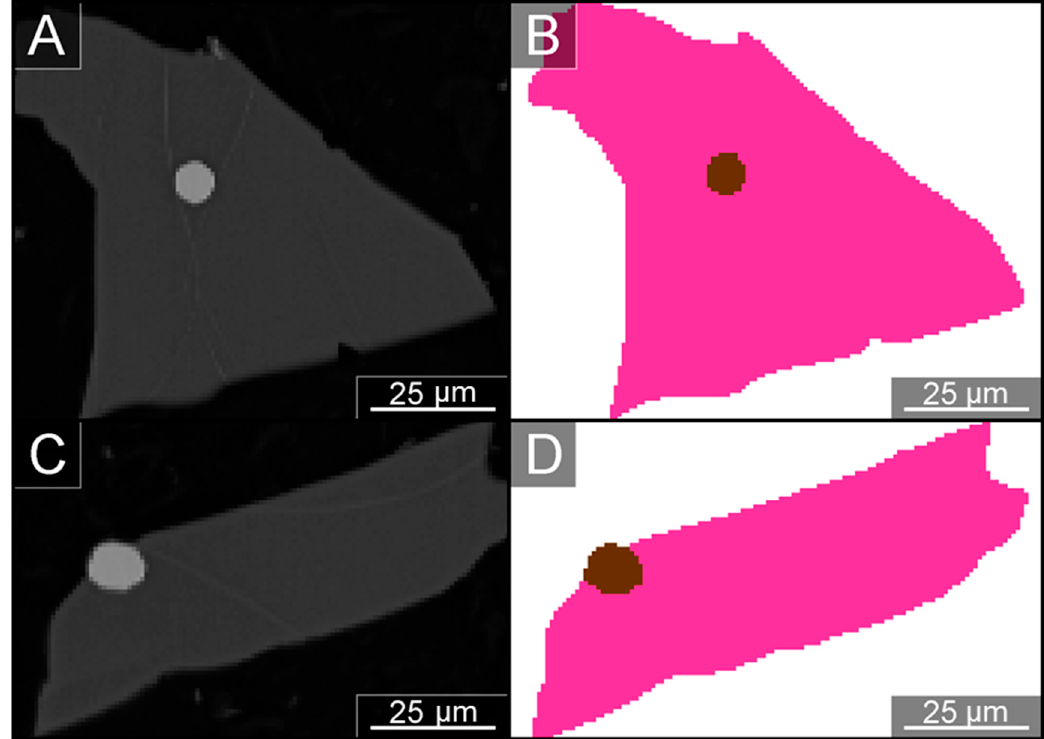
Figure 13. Typical particles with copper inclusion of sample H: (left, A and C ) grayscales from BSE images; (right, B and D ) associated false color images indicating different phases: pink (amorphous Al slag phase), brown (Cu-metal).